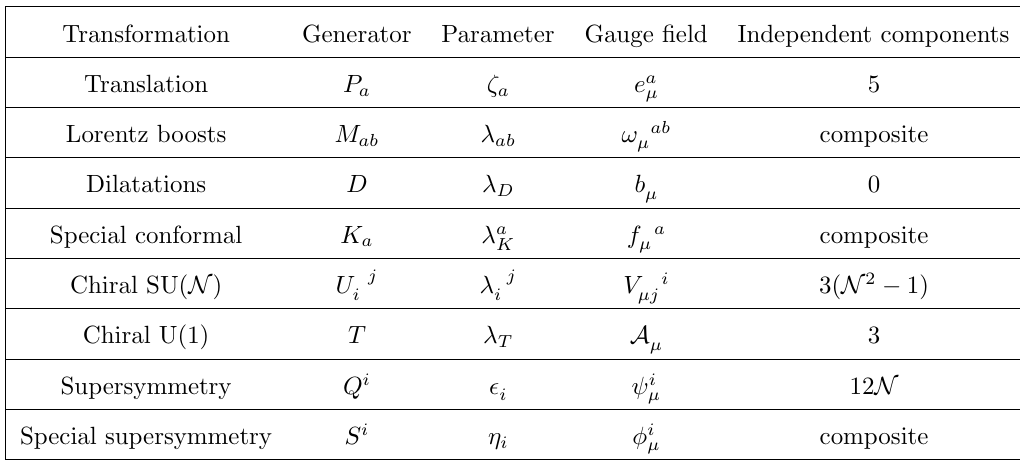
Table 3 . The symmetries of the superconformal group in four dimensions SU(2 ; 2 jN ), their genera- tors, parameters and gauge (cid:12)elds. The (cid:12)nal column denotes the number of independent components of the gauge (cid:12)elds. The curvature constraints (2.36) have already been imposed and the redundant gauge degrees of freedom have been subtracted in this component counting. The table also clearly shows that in the case of N > 1 one has to include matter (cid:12)elds in the full multiplet to ensure that the number of fermionic and bosonic components are